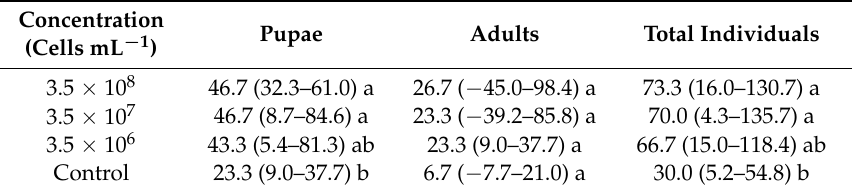
Table 4. Mortality of Drosophila suzukii pupae and emerged adults 9 days after dipping the pupae in Photorhabdus luminescens at different concentrations.